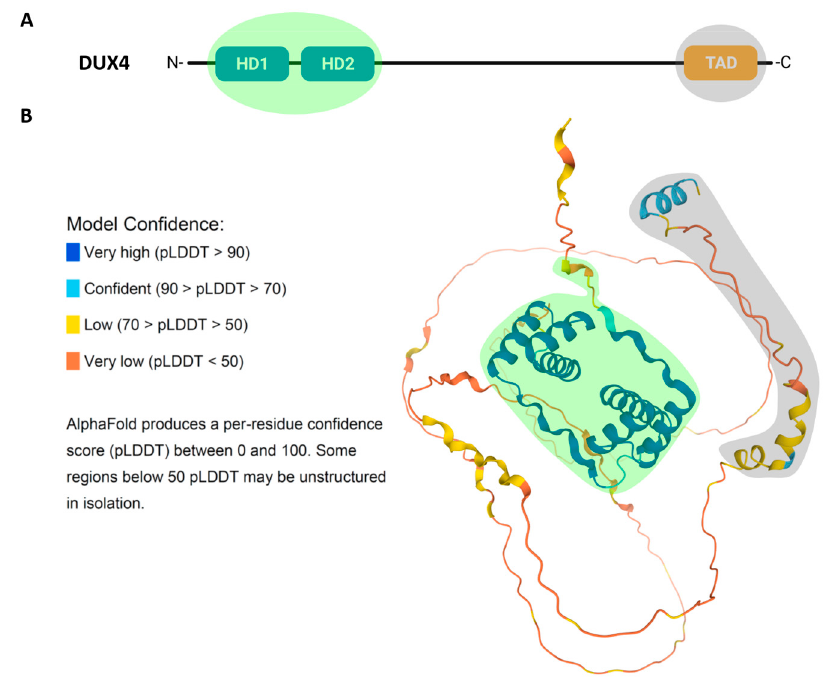
Figure 2. ( A ) Schematic representation of DUX4 containing two homeodomains (HD1 and HD2) at the N-terminus (green shading) and the transactivation domain (TAD) at the C-terminus (grey shading). ( B ) Prediction of DUX4 3D structure using AlphaFold. DUX4 DNA binding domain (green shading) and the C-terminal region containing the DUX4 transcription activation domain (grey shading) have a well-defined tertiary structure, while the rest of the protein is predicted to be mainly disordered (unstructured).